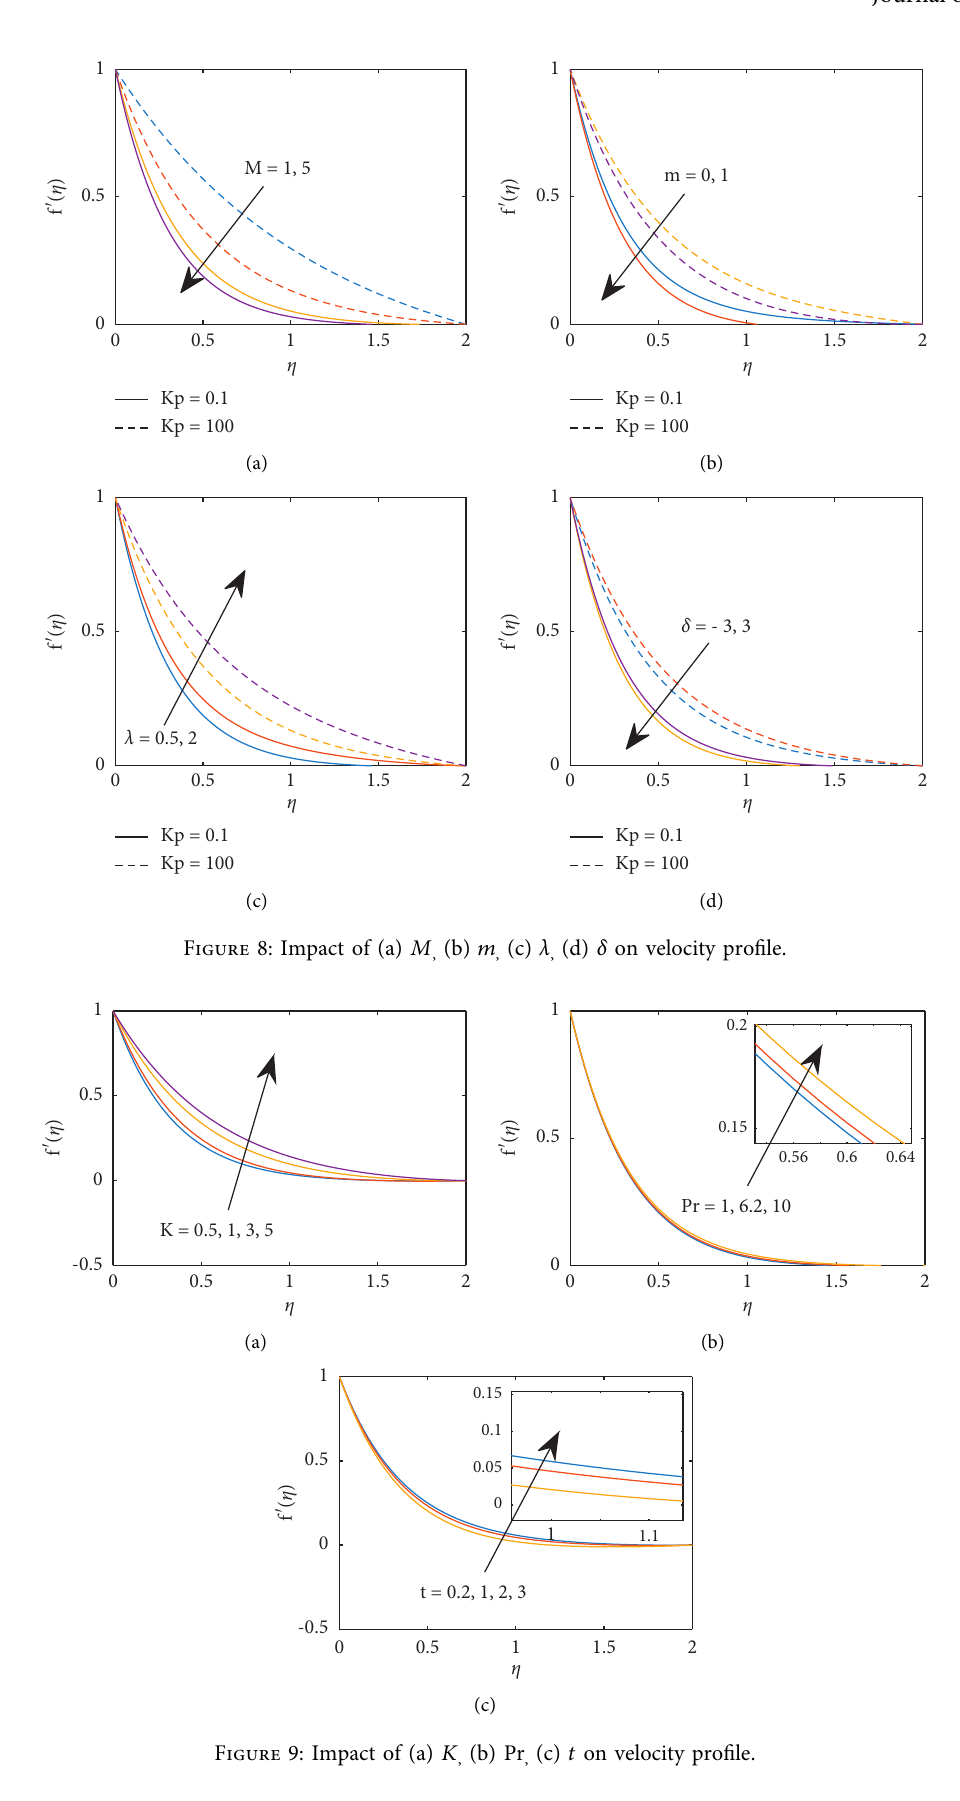
t on velocity , (b) Pr , (c)